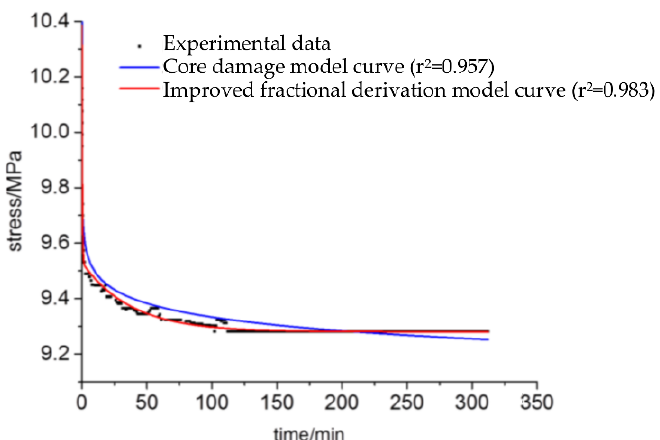
Figure 5. The comparisons of the core damage model and the fractional derivative model to the relaxation data of lean coal sample r-4 at the strain of 1.2%.